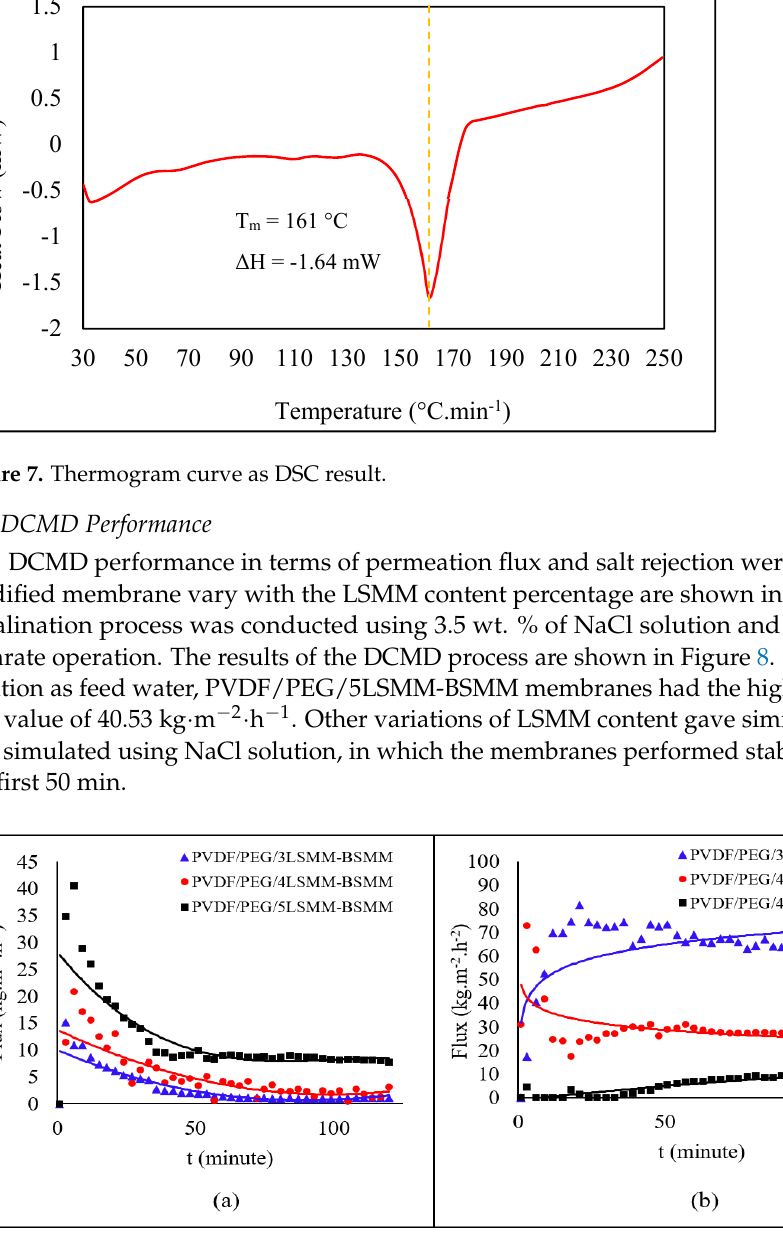
Figure 8. Membrane flux permeation of ( a ) 3.5 wt. % saltwater and ( b ) seawater in the desalination process.